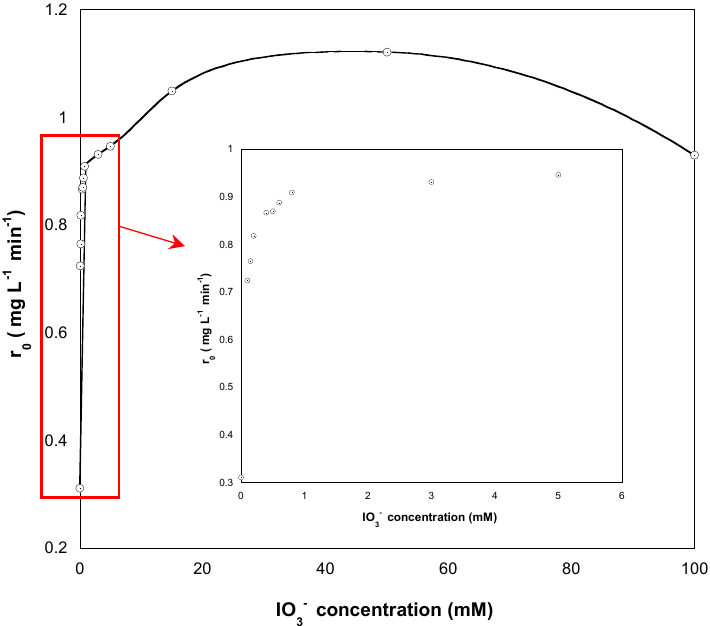
Figure 6. Dependence of initial rate of SO degradation on IO 3 − concentration in the range 0.1–100 mM by UV/TiO 2 /IO 3 − process ([TiO 2 ] = 0.4 g∙L − 1 , [SO] = 10 mg∙L − 1 , T = 25 ± 2 °C and pH~6).